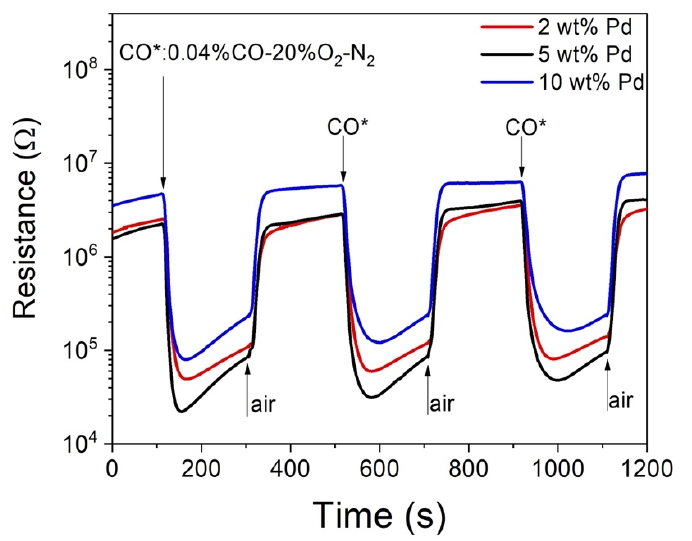
Figure 4. Room-temperature response to 0.04% CO-20% O 2 -N 2 and recovery in air for Pd-SnO 2 nano-ceramic samples with 2, 5, and 10 wt% Pd, separately.